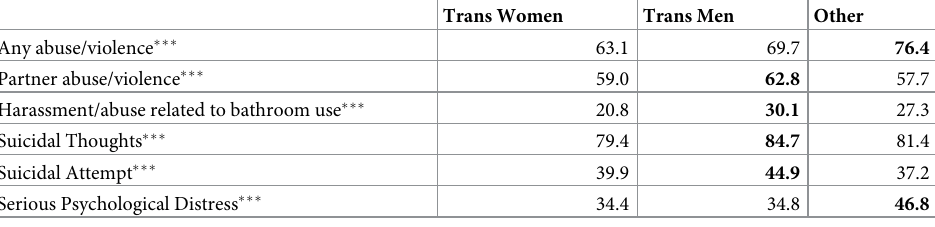
Table 4. Bivariate analyses of prevalence (%) of each type of abuse and mental health outcomes, by gender identity (weighted sample =